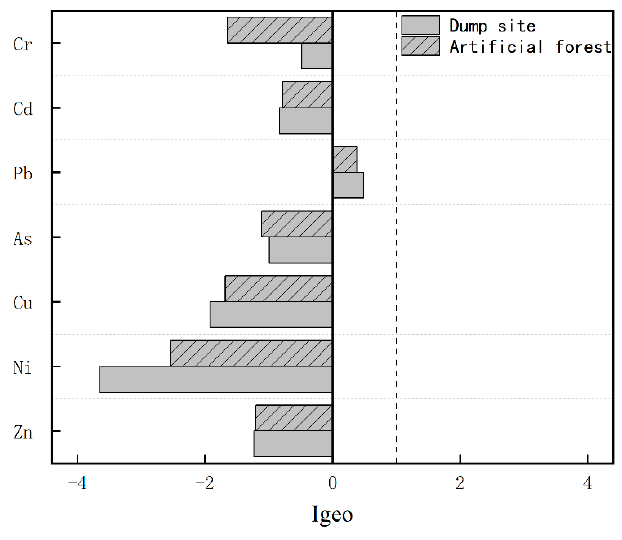
Figure 3. Distribution diagram of ground accumulation index. Table 3. Potential ecological risk index of heavy metals in different regions.